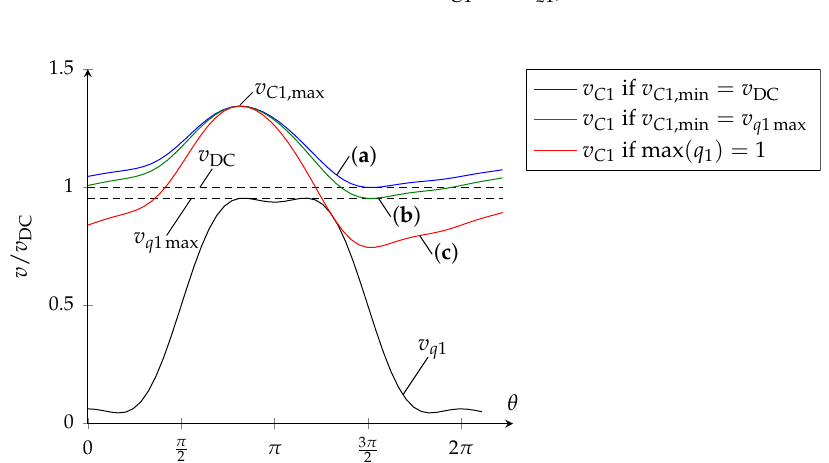
Figure 2. Three capacitor designs for the same energy ripple ∆ e C 1 and maximum cell voltage v C 1,max but different choices for the minimum voltage v C 1,min , leading to different voltage ripples ∆ v C 1 : ( a ) the minimum voltage equals the DC voltage; ( b ) the minimum voltage equals the maximum injected arm voltage; ( c ) the minimum is the lowest possible value satisfying v q 1